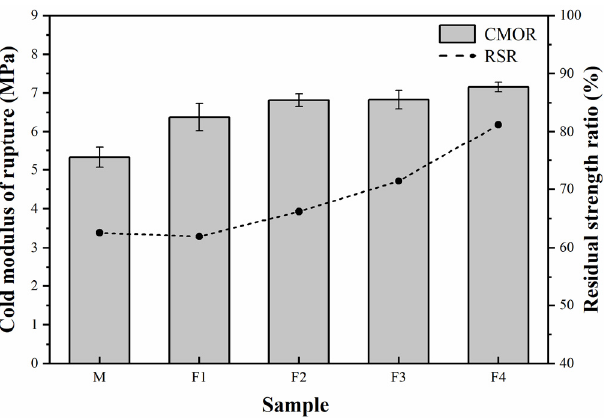
Figure 8. CMOR and RSR of the castable specimens after heat treatment at 1450 °C for 3 h.